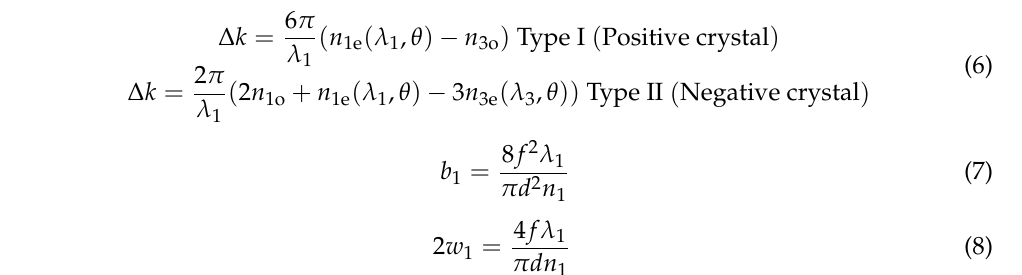
(11) Figure 5. ( a ) The diagram of phase-matching angle θ m dispersion; ( b ) The diagram of spectrum peak shift in the frequency domain. 3. Simulation Results and Discussion 3.1. The Investigated Centrosymmetric Crystals In this paper, three centrosymmetric crystals, Alpha Barium Borate ( α -BBO), calcite, and rutile, are investigated considering their transparency, THG conversion efficiency, broad phase-matching range, and availability. Here, it should be clarified that α -BBO is a typical centrosymmetric crystal, which is different from the non-centrosymmetric Beta Barium Borate ( β -BBO) in our previous study, although they have a similar refractive